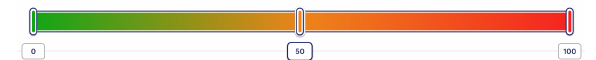
Figure 2. Gradient scale key for model representation from green to